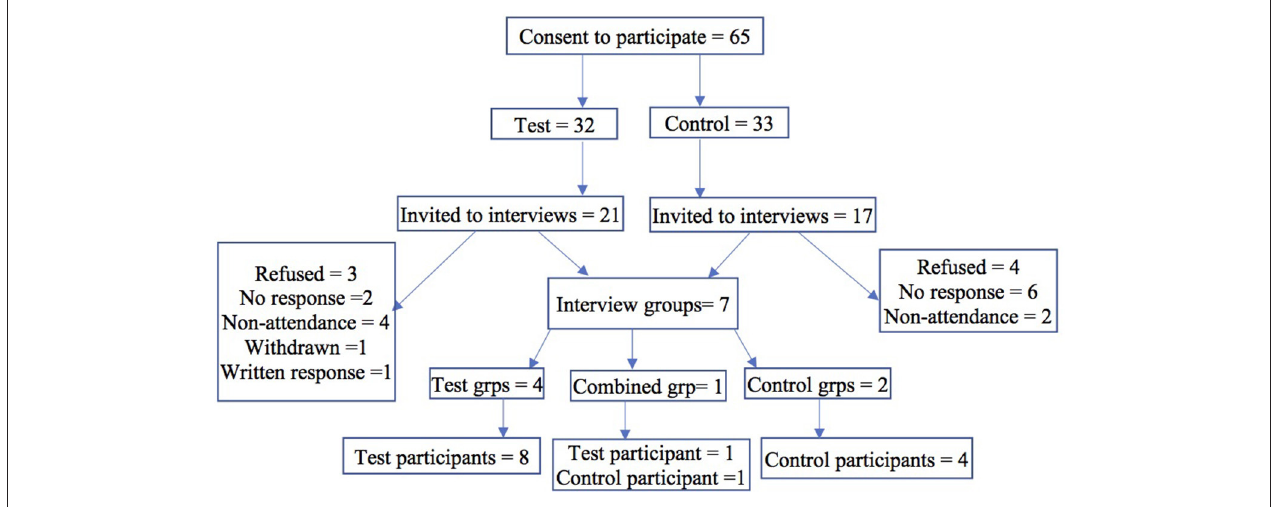
FIGURE 1 | Participant flow chart.